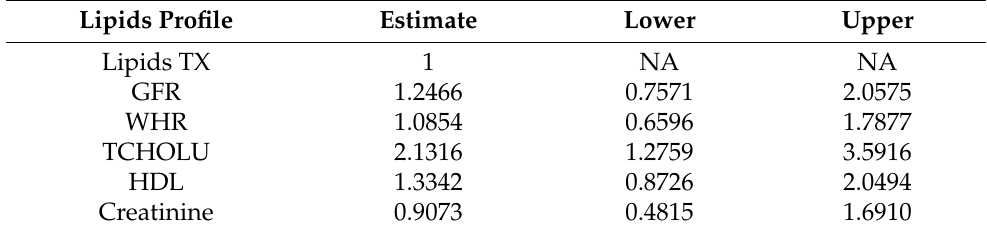
Table 11. Odds Ratio with 95%